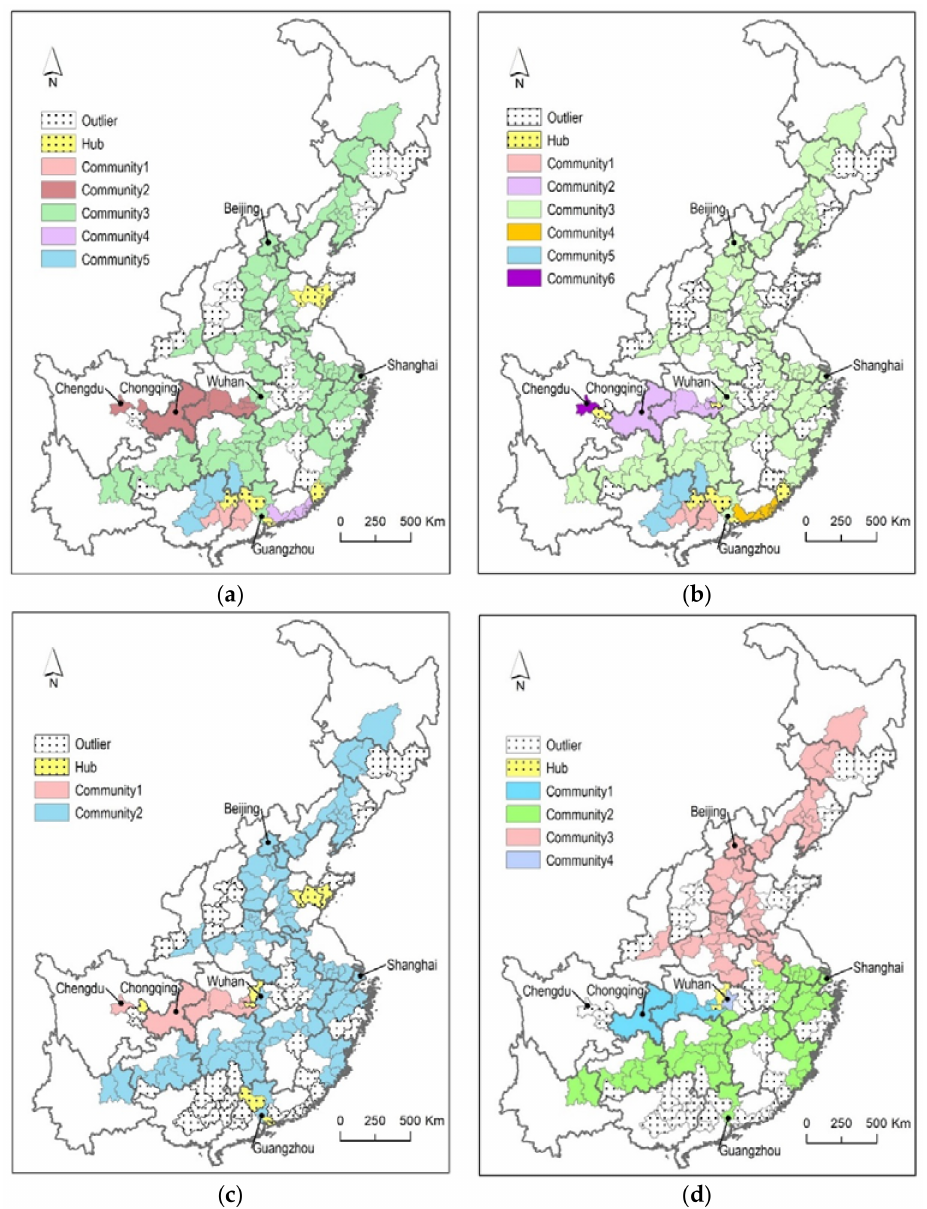
Figure 13. Community results for SCAN and DASSCAN in the high-speed train network: ( a ) SCAN ( ε = 0.75, µ = 3); ( b ) DASSCAN ( ε = 0.75, µ = 3); ( c ) SCAN ( ε = 0.75, µ = 5); and ( d ) DASSCAN ( ε = 0.75, µ =